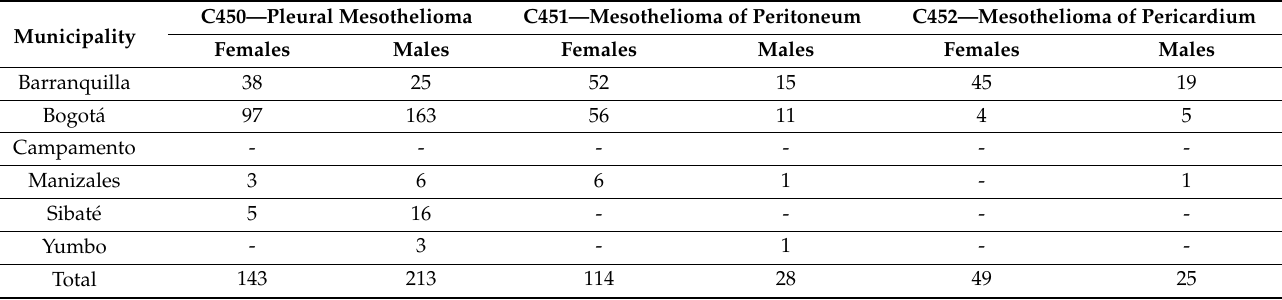
Table 8. Number of cases of pleural, peritoneal, and pericardial mesotheliomas attended by health providers from 2015 to the first half of 2021 (as of 30 June